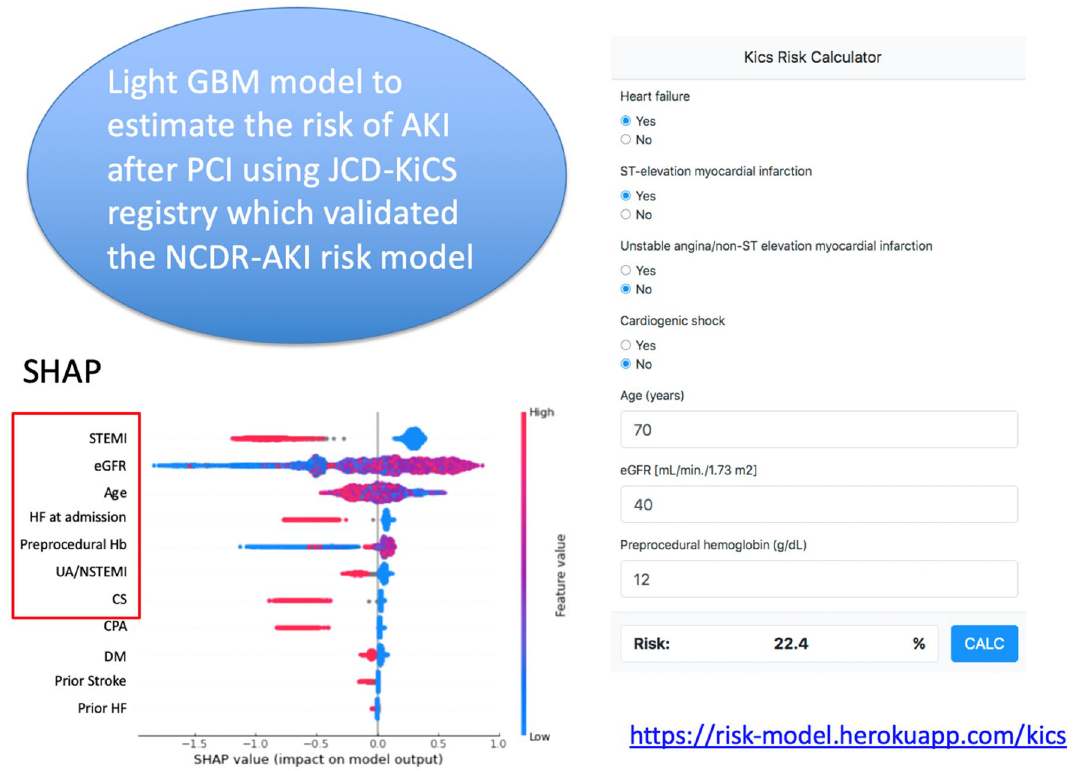
Figure 7. (Left) SHAP model to estimate important variables with the light gradient boosting model using the 12 NCDR variables except intra-aortic balloon pump. The features are sorted in descending order by Shapley values. Abbreviations: AKI: acute kidney injury; CS: cardiogenic shock; CPA: cardiopulmonary arrest; DM: diabetes mellitus; GBM: gradient boosting model; Hb: hemoglobin, HF: heart failure, IABP: intra-aortic balloon pump; JCD-KiCS: Japanese Cardiovascular Database-Keio Inter-hospital Cardiovascular Studies; NCDR: National Cardiovascular Data Registry; STEMI: ST-elevation myocardial infarction; UA/NSTEMI: unstable angina/non-ST elevation myocardial infarction. (Right) Kics risk calculator (https:// risk- model. herok uapp. com/